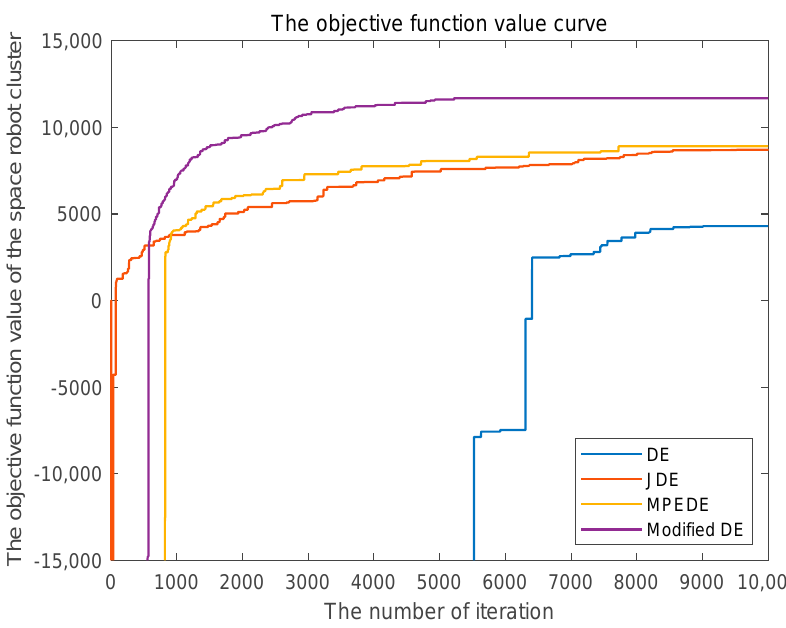
Figure 8. Value of the objective function when the space-robot cluster energy is 6000.